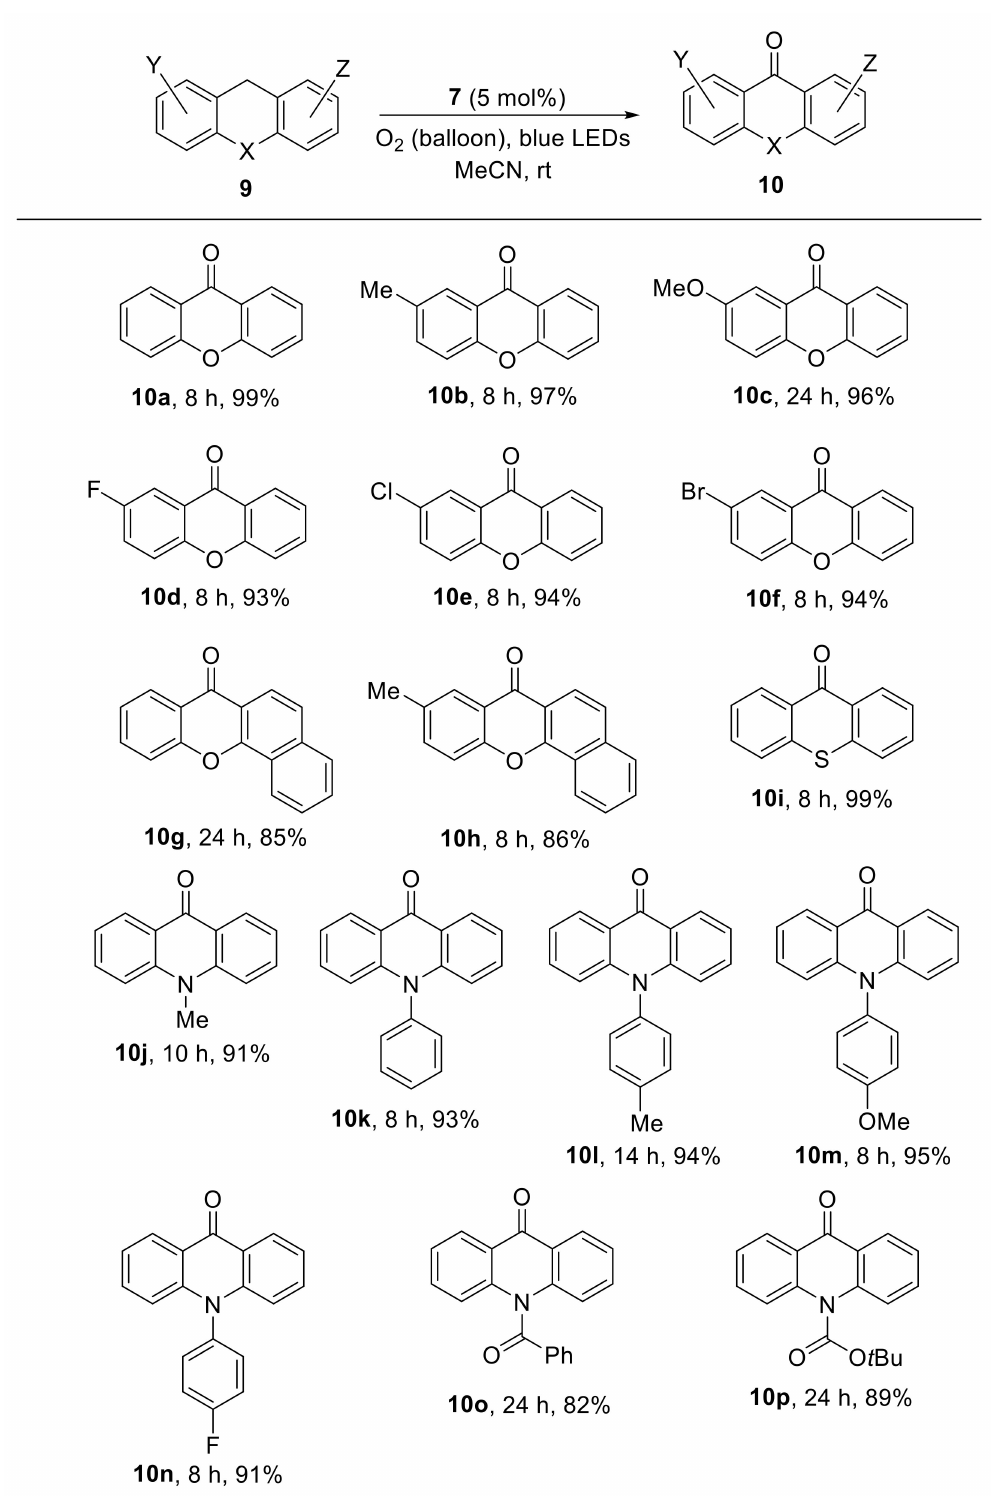
Figure 2. Photocatalyzed oxidation of 9 H -xanthenes, 9 H -thioxanthene and 9,10-dihydroacridines. Reaction time and yield, after isolation by flash chromatography, detailed for each